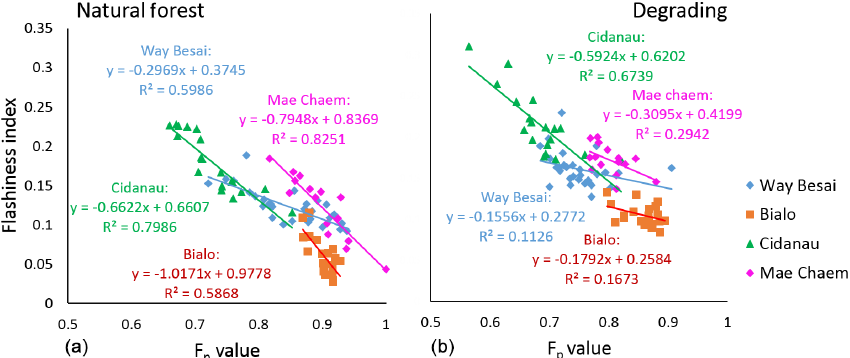
Figure 8. Relationship between F p value and R–B Flashiness index across years in four Southeast Asian watersheds under a “natural forest” and “degrading” scenario, simulated with the GenRiver model. Table 6. Comparison of metrics at various points in the causal network (Fig. 2 of Part 1, van Noordwijk et al., 2017) that can support watershed management and prevention of flood damage on the list of seven issues (I–VII) introduced in Fig. 1 Part 1 ∗